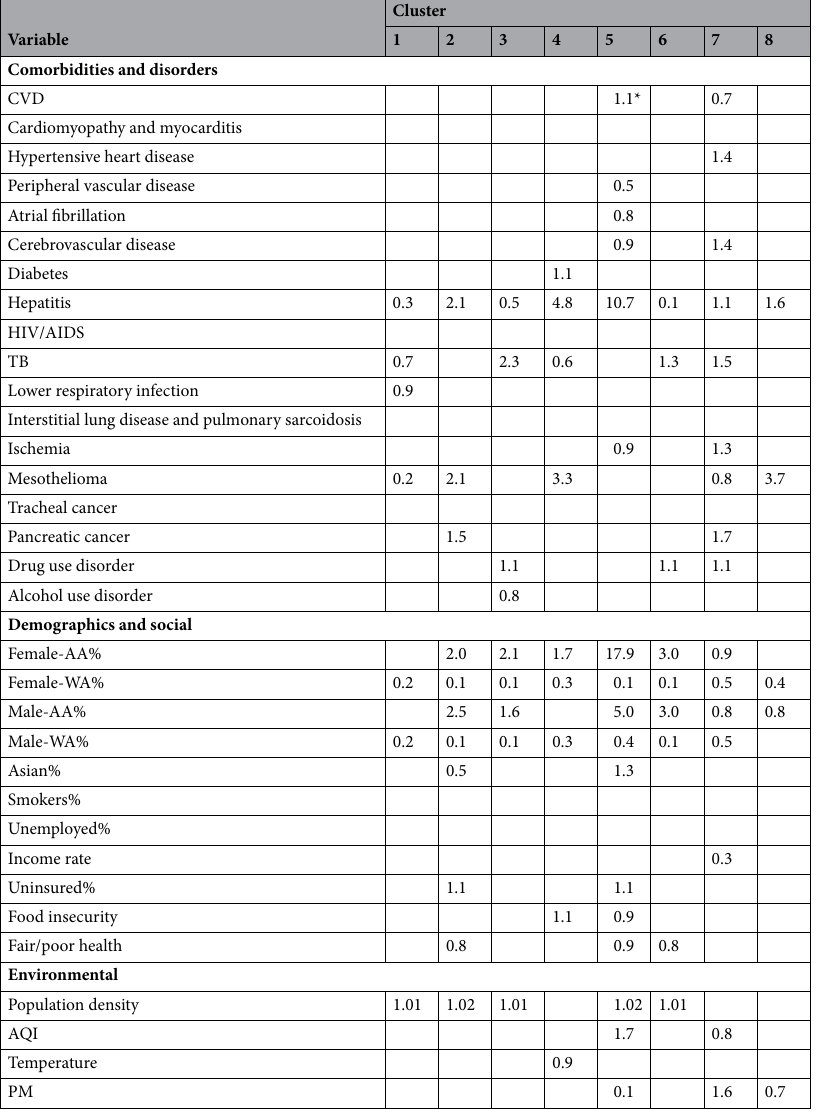
Table 5. 1st Wave (Mar 25–Jun 3, 2020): significant risk factors and their odds ratios in each cluster compare to cluster 0 (counties with MIR = 0). Blank spots indicate the insignificant risk factors. *For instance, OR 1.1 means that 1% increase in CVD MR is associated with a 10% increase in the relative log odds of being in cluster 5 vs. cluster 0 (MIR =